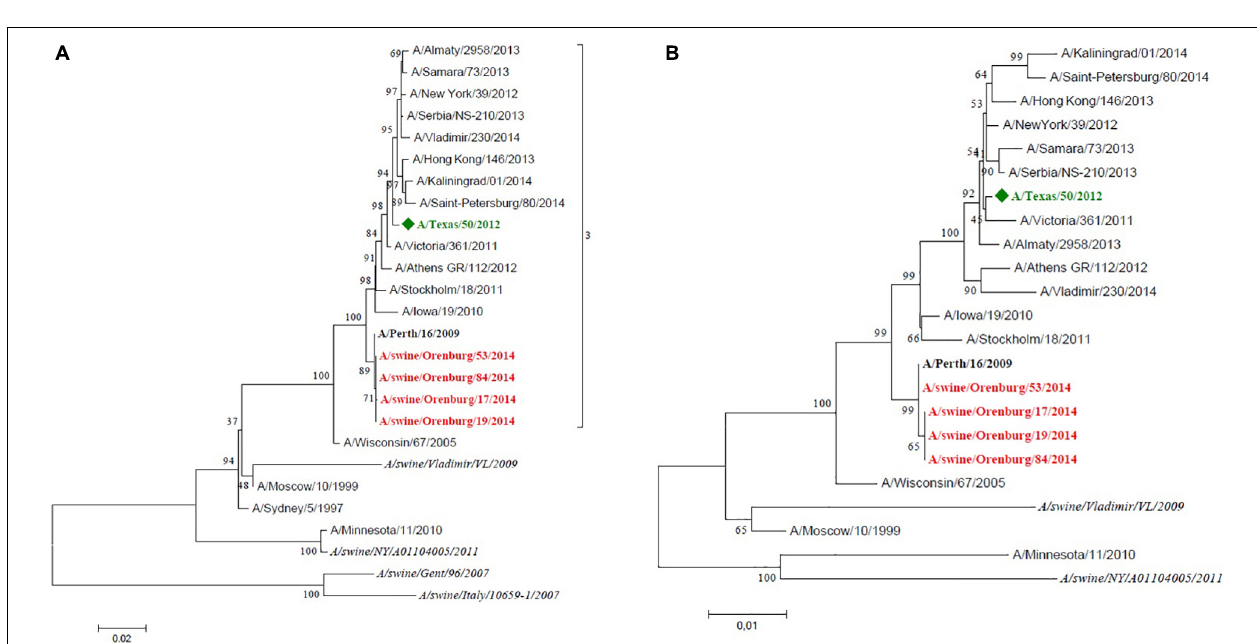
FIGURE 2 | Maximum likelihood tree for swine influenza A HA (A) and NA (B) of H1N1pdm09 isolated in 2014. The vaccine strain at that time is shown in blue. Reference strains are in black bold. Swine strains from this study are shown in red.